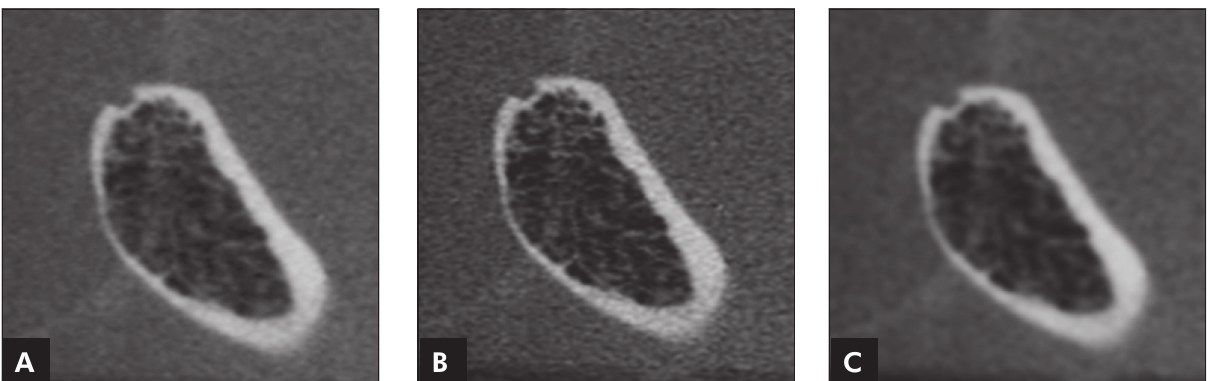
Figure 2 - Cross-sectional slices of the condyle in Figure 1 reconstructed in protocols 1, 2 and 3: ( A ) 0.2 mm-thick section and no filter; ( B ) 0.2 mm-thick section and Sharpen Mild filter; ( C ) 0.2 mm-thick section and S9